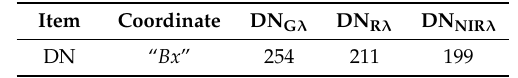
Table 10. Calibration bracket mean digital number (DN) values 1 per camera